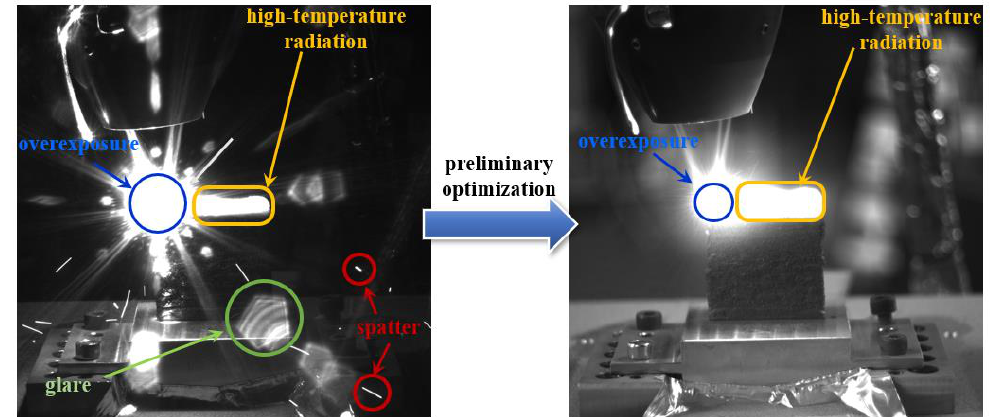
Figure 4. Interference factors in laser repair.